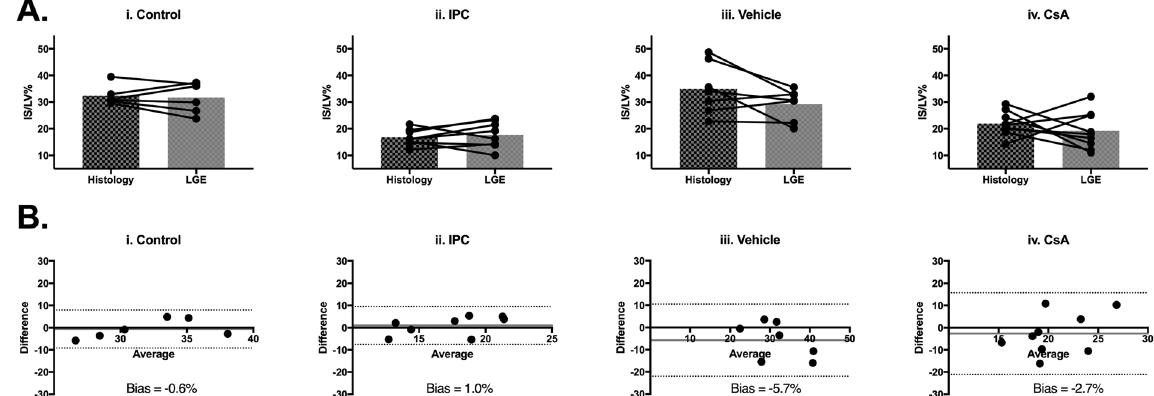
Figure 3. Validation of in vivo LGE to determine MI size upon IRI. ( A ) Quantification of infarct size as a fraction of left ventricle area (IS/LV%) by histological staining and LGE for individual animals in control group (n = 6) (i), IPC group (n = 10) (ii), vehicle group (n = 8) (iii) and CsA group (n = 9) (iv). Mean ± standard deviation values are provided in Supp. Table 1. ( B ) Bland-Altman plots comparing histological and LGE methods of estimating IS/LV% for all groups (i–iv).